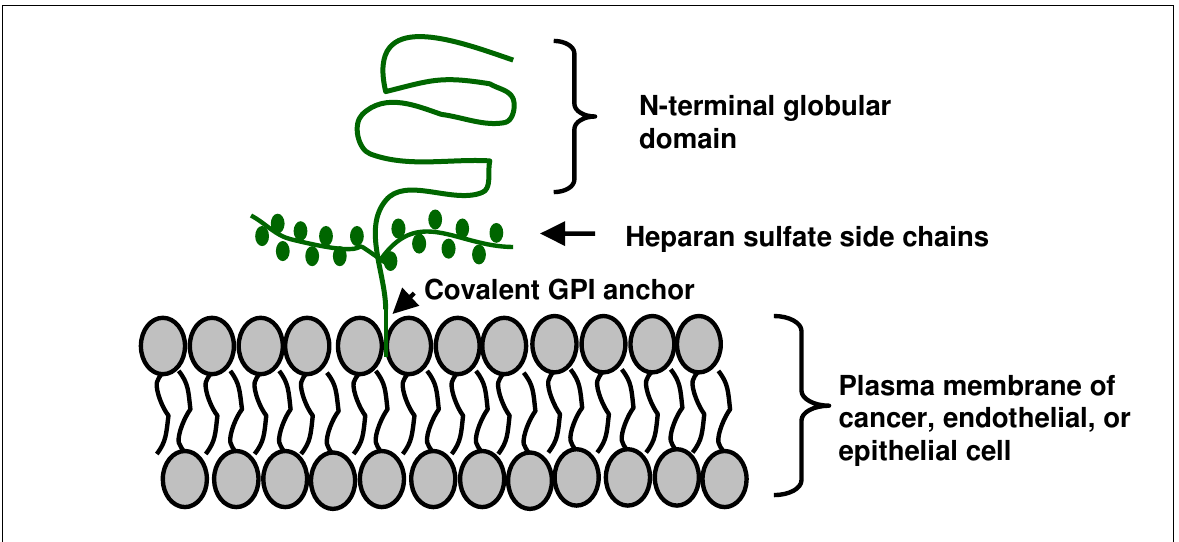
FIGURE 2. Schematic diagram of the GPC1 protein structure. Major features include the N-terminal globular domain, which contains several conserved cysteine residues that form intramolecular disulfide bonds, the C-terminal heparan sulfate side chains important for the interaction with signaling molecules, and the glycosyl-phosphatidylinositol (GPI) anchor, which covalently links GPC1 with the plasma